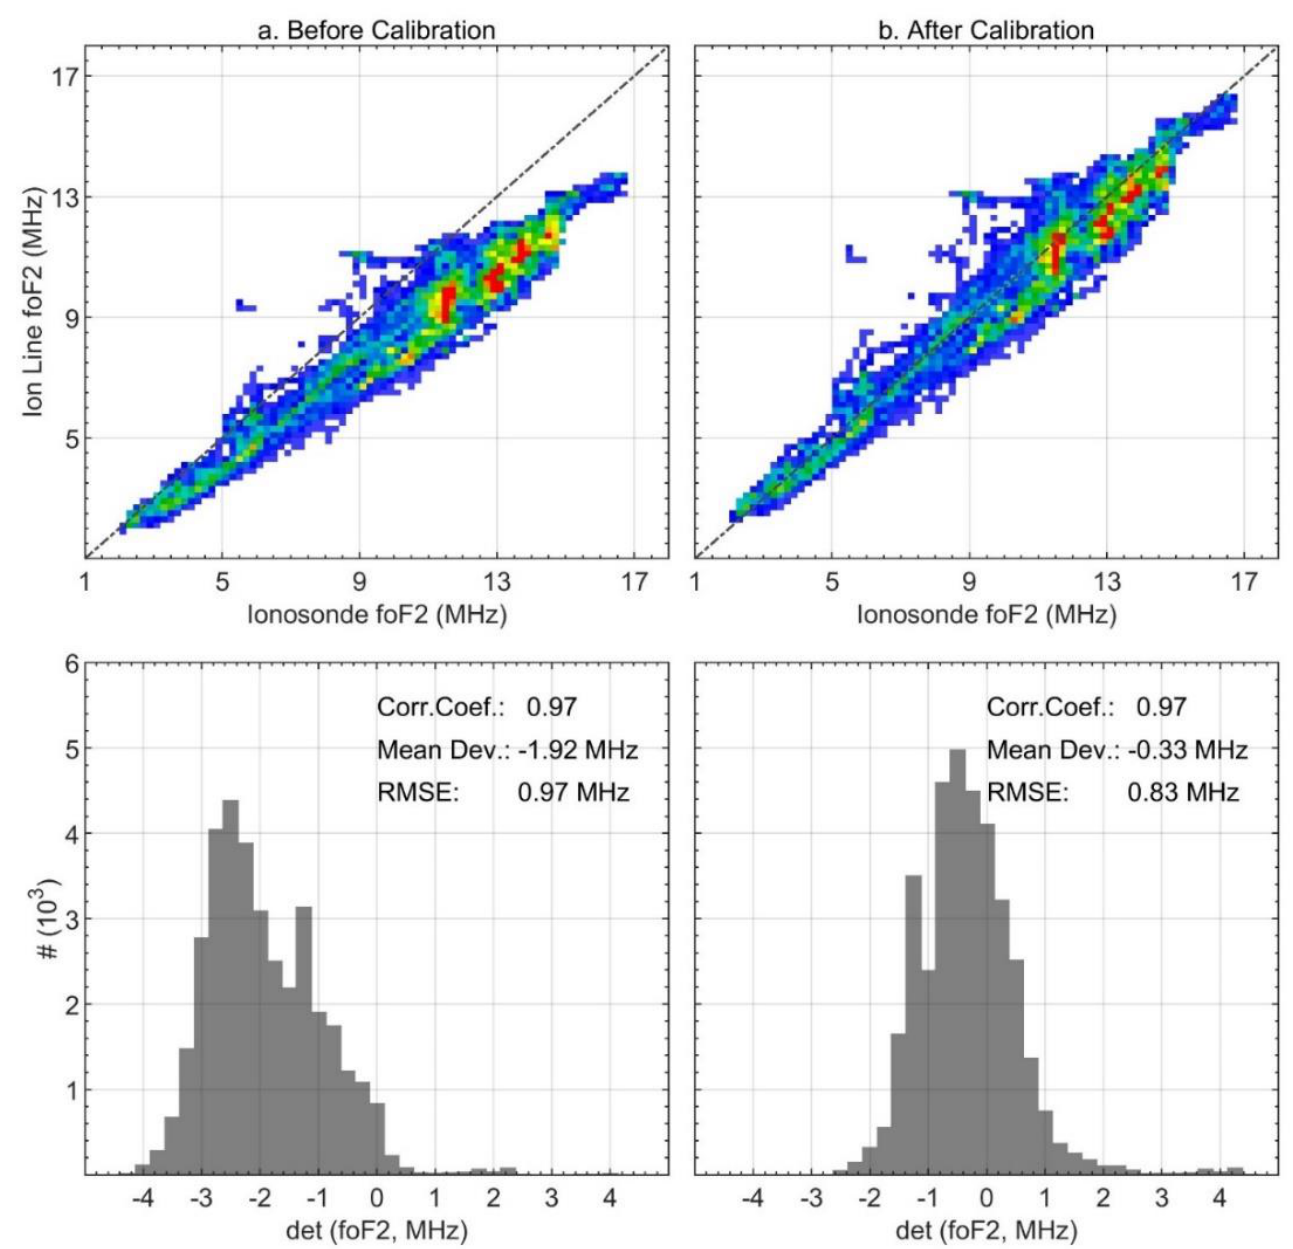
Figure 5. Versus plot between ionosonde measured ionospheric critical frequency ( f o F 2 ) and SYISR ion line-derived f o F 2 (top panels) and the corresponding statistical histogram of their difference (bottom panels) for both before calibration ( left ) and after calibration ( right ) during the one-month long experiment of 12 March 2022 to 10 April 2022. The corresponding correlation coefficient, mean deviation, and root mean square error between SYISR and Ionosonde f o F 2 were also calculated in both conditions. The color in the top panel represents the data number intensity in each pixel.